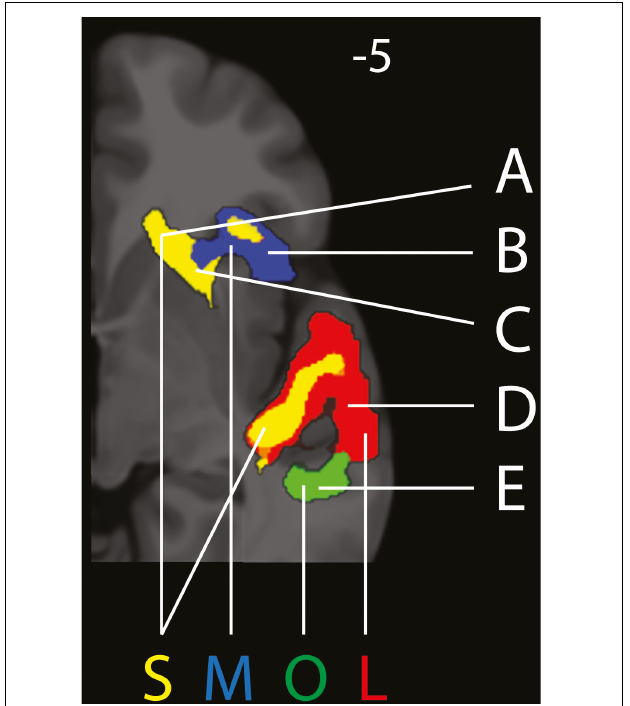
FIGURE 2 | Excerpt from right hemisphere of separation of (in red) LISTENING (L), (in yellow) SUPRESSION (S), (in blue) MAINTENANCE (M) and (in green) OMISSION (O). A = Caudate Nucleus, B = Anterior Insula, C = Putamen, D = Superior Temporal Gyrus, E = Middle Temporal Gyrus. Panel at MNI z = –5 on the axial plane. (Figure made partly with MRIcroGL, with small cluster removal). FIGURE 3 | Red areas, overall activity during listening for the first 16 s. Yellow